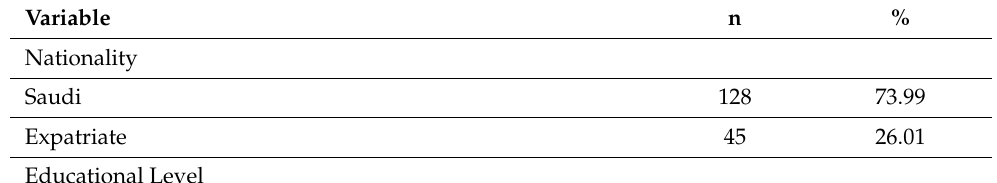
Table 1. Demographic profile of the